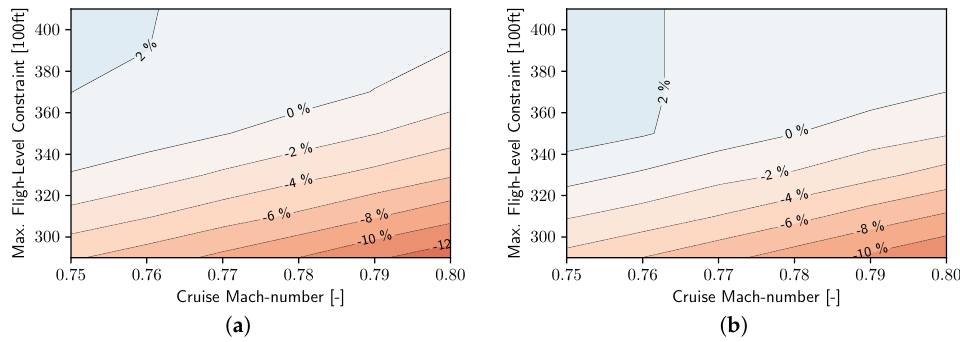
Figure 12. LoD difference for PtL concept D261+SAF ( a ) and LH2 concept D261+H2 ( b ).